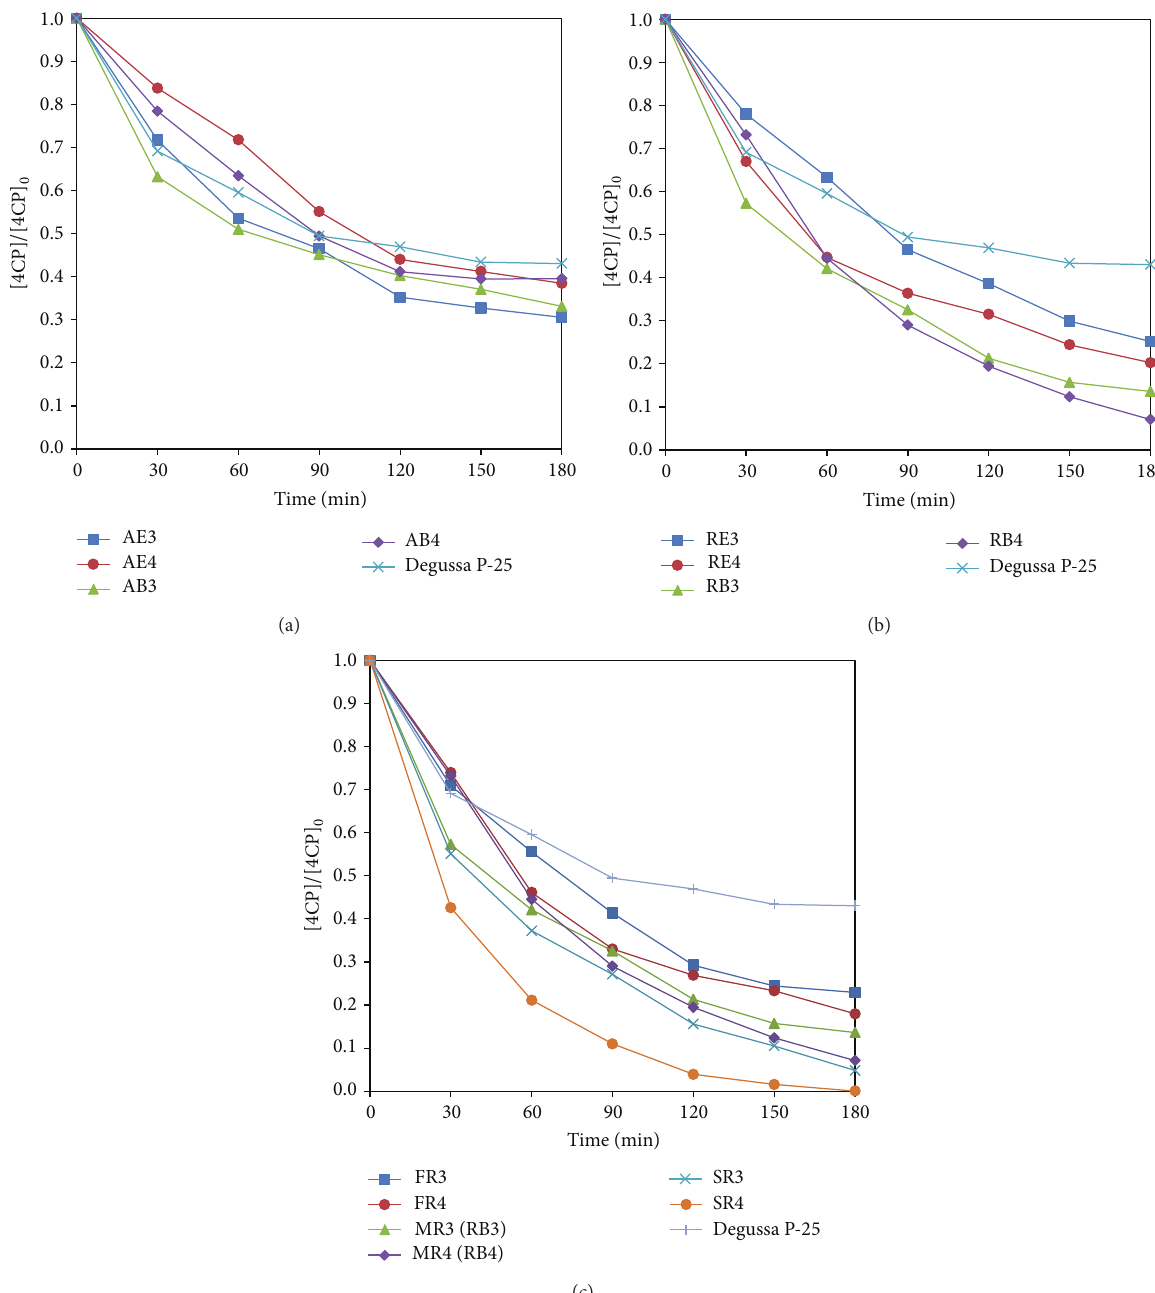
Figure 6: Photocatalytic degradation profiles of 4CP over the mesoporous titania samples synthesized with (a) room temperature, (b) rotary evaporator, (c) drying rate in rotary evaporator, and Degussa P-25.